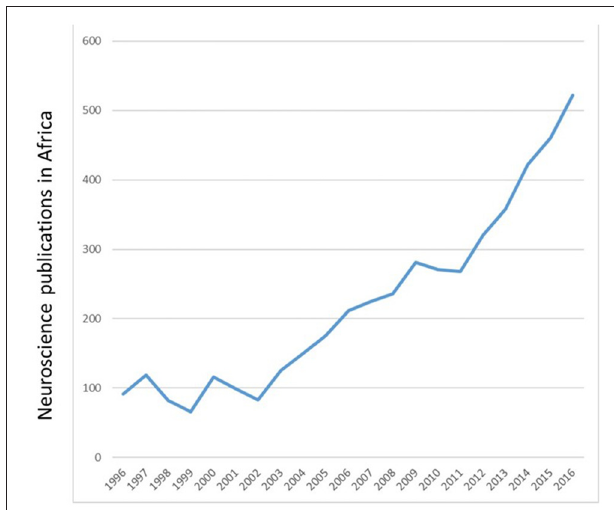
FIGURE 2 | Number of Neuroscience publications per annum from 1996 to 2016. Adapted from SCImago (2007)